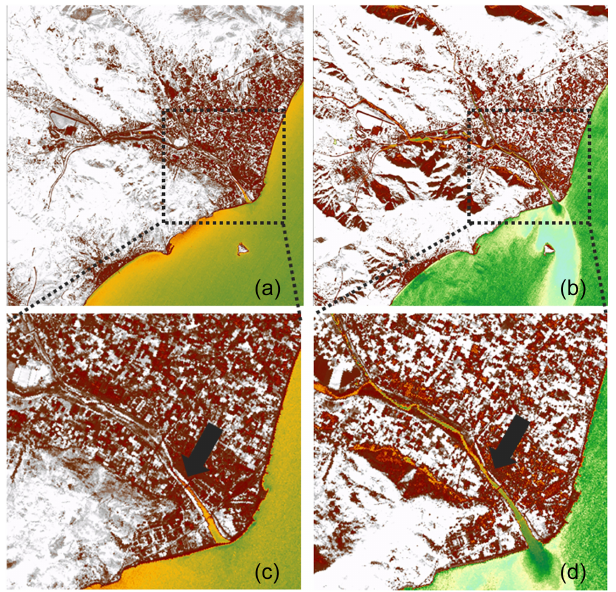
Figure 6. NDWI in false colour gradient calculated over Albenga on 9 October (a) and on 28 November 2016 (b) ; close up of the Centa river estuary and the inhabited area around the river shores on 9 October (c) and on 28 November 2016 (d) . Image contains modified Copernicus Sentinel data